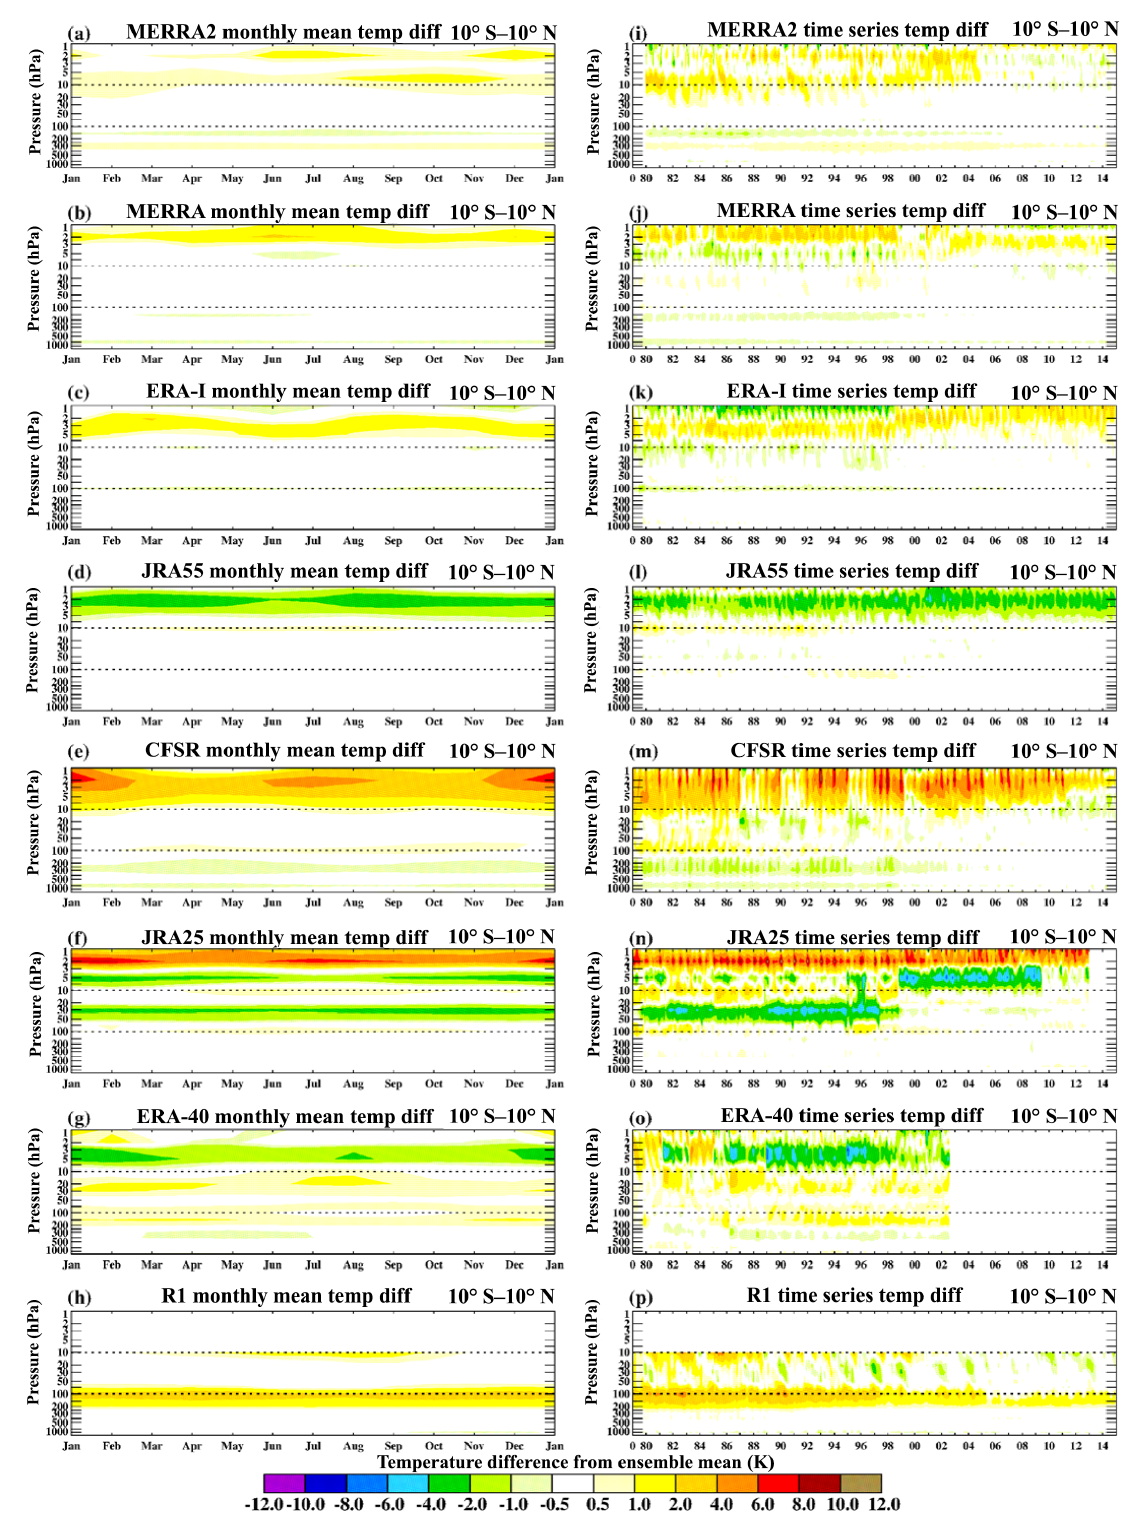
Figure 8. Same as Fig. 6 but for the 10 ◦ S–10 ◦ N latitude zone.